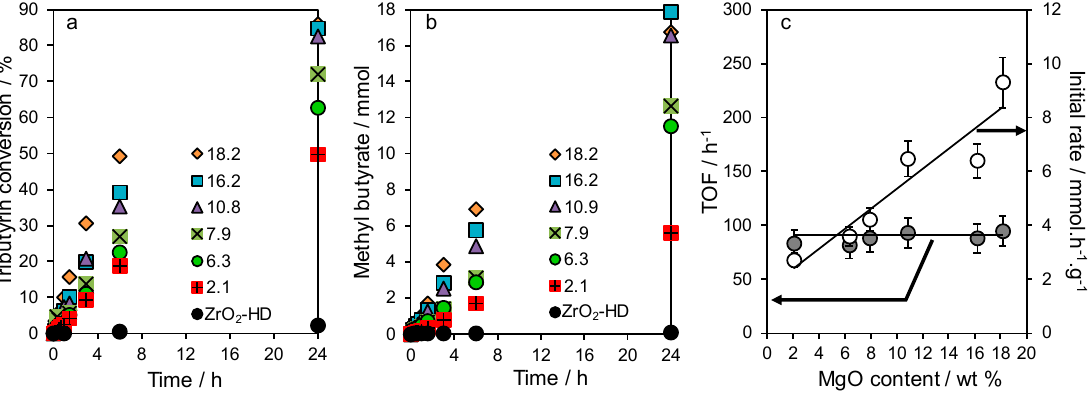
Figure 6. Tributyrin transesterification with methanol over xMZ–HD catalysts: ( a ) conversion; ( b ) methyl butyrate yield; and ( c ) mass-normalized initial rates and turnover frequency (TOF) per base site.